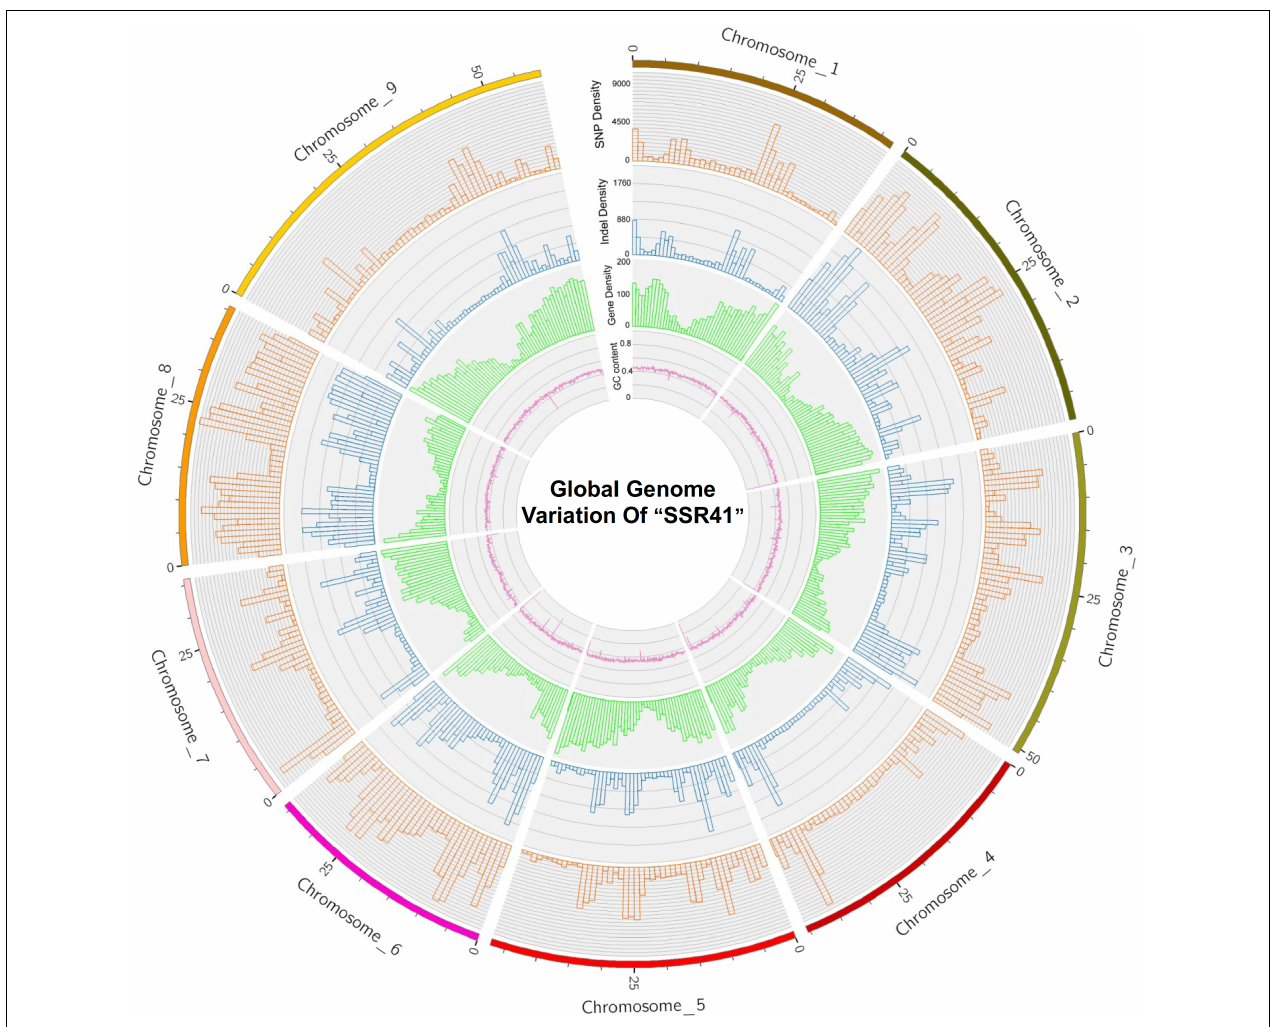
FIGURE 2 | A circular plot showing “SSR41” genome sequence features. An orange bar shows single nucleotide polymorphism (SNP) density, a blue bar shows insertion/deletion (InDel) density, a green bar shows gene density, and a purple line shows GC